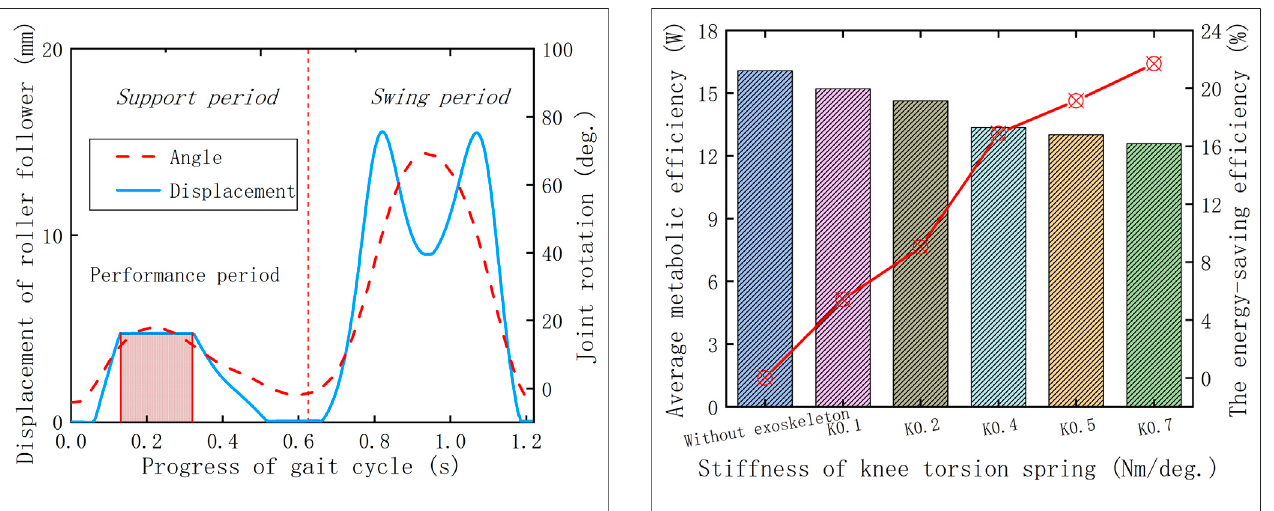
FIGURE 12 | Motion characteristics of the coupling mechanism.